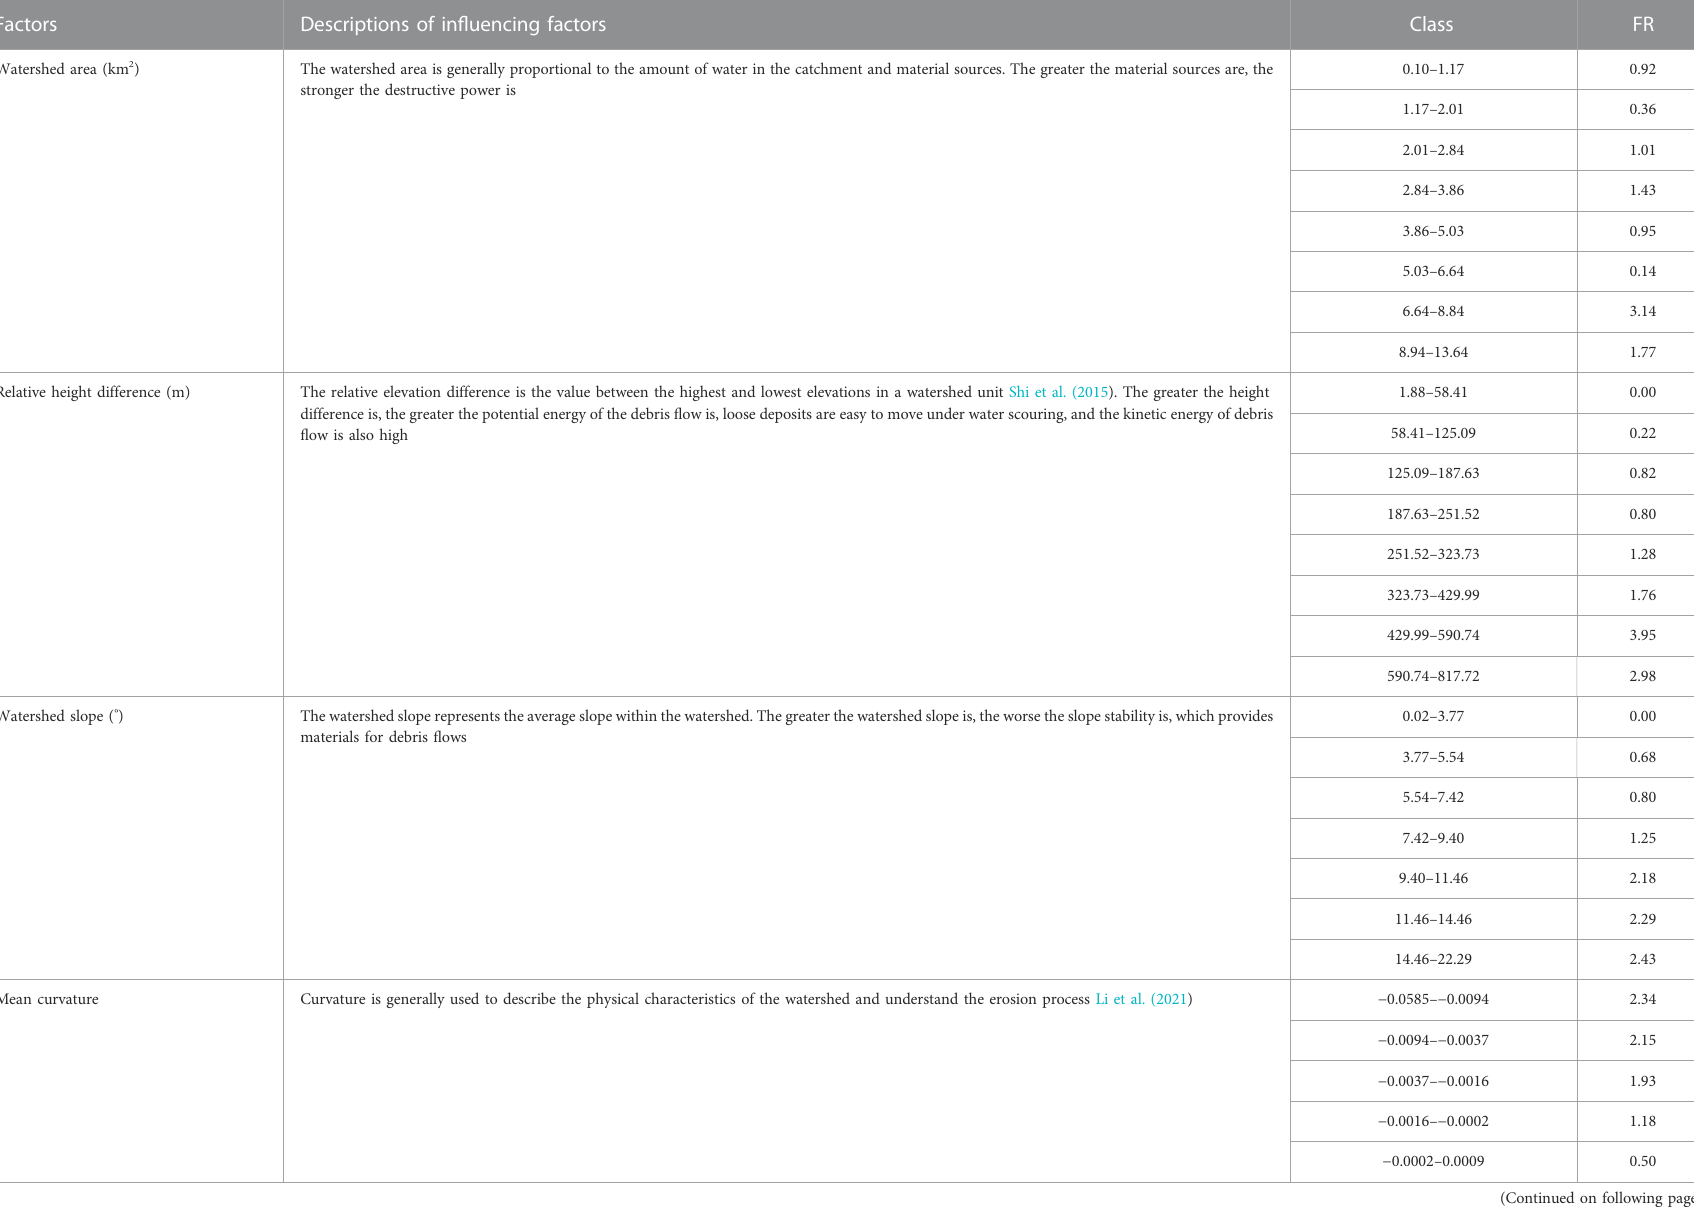
TABLE 3 Description and FRs of all the in fl uencing factors (HWUs with a fl ow threshold of 1,000). Factors Descriptions of in fl uencing factors Watershed area (km 2 ) The watershed area is generally proportional to the amount of water in the catchment and material sources. The greater the material sources are, the stronger the destructive power is